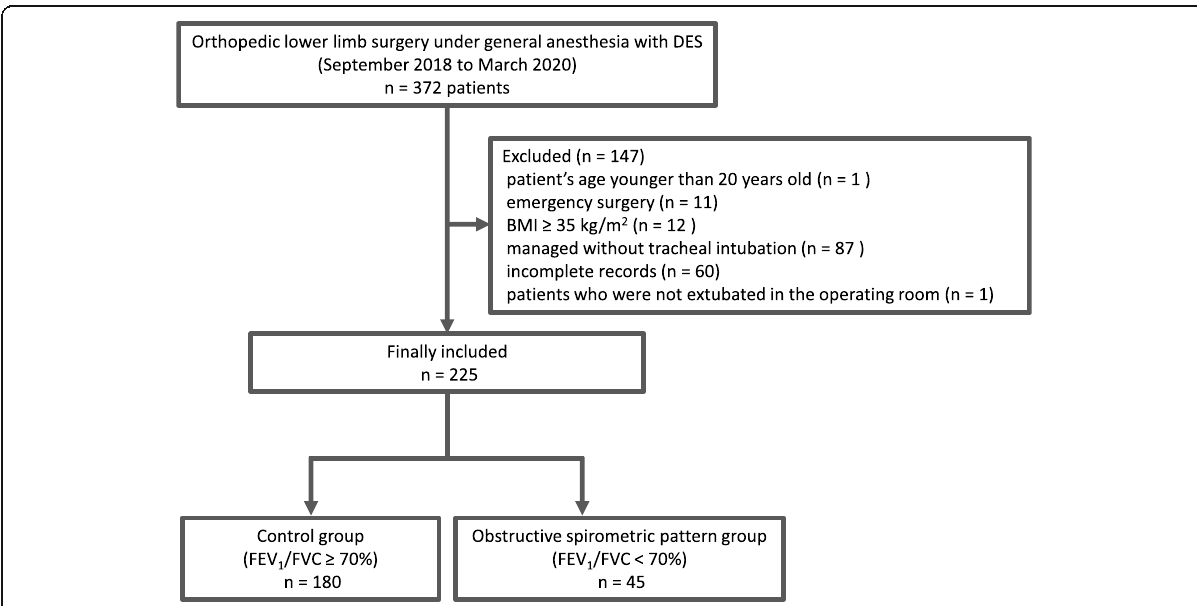
Fig. 1 Flow chart for patient ’ s selection. Flow diagram detailing the selection of patients included in the retrospective analysis. Ninety-one patients were excluded due to non-curative surgery, multiple procedures for the cancer during the study period, incomplete records, and receiving both forms of anesthesia during